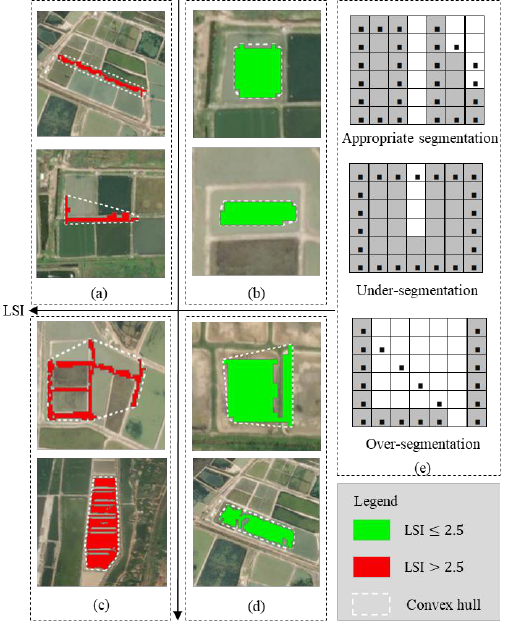
Figure 6. Introduction of the segmentation degree detection method: ( a ) examples of over-segmented objects (LSI > 2.5 and RPOC ≤ 1.5); ( b ) examples of appropriately segmented objects (LSI ≤ 2.5 and RPOC ≤ 1.5); ( c ) examples of under-segmented objects (LSI > 2.5 and RPOC > 1.5); ( d ) examples of under-segmented objects (LSI ≤ 2.5 and RPOC > 1.5); ( e ) an illustration of these segmentation